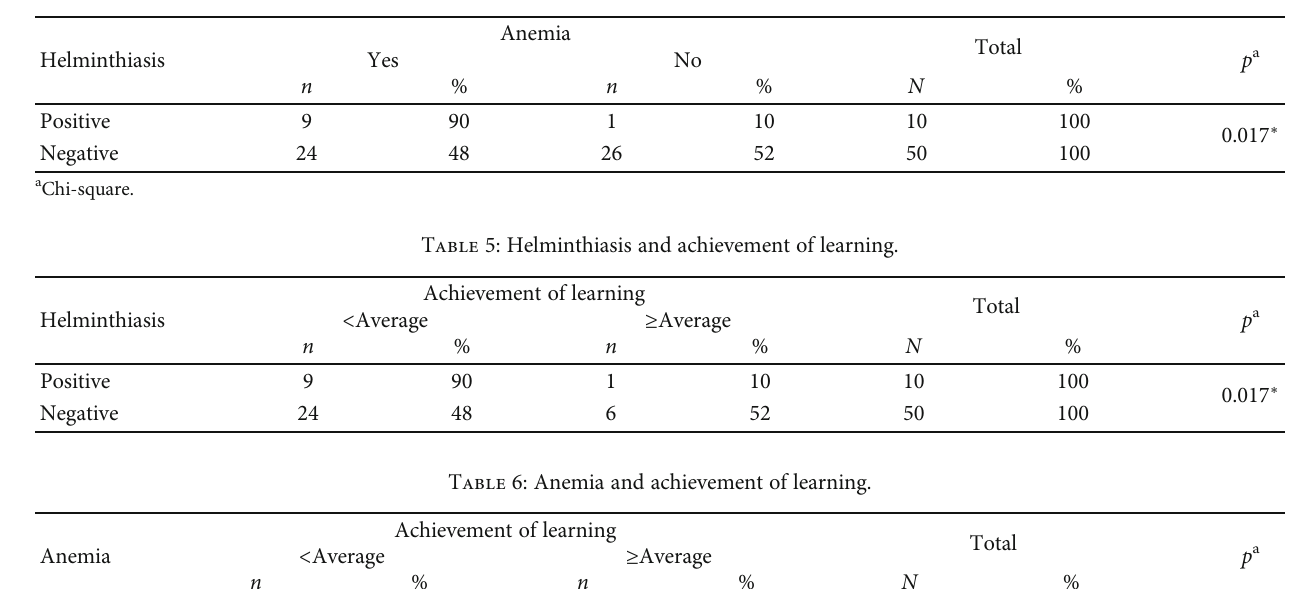
Table 4: Helminthiasis and anemia.